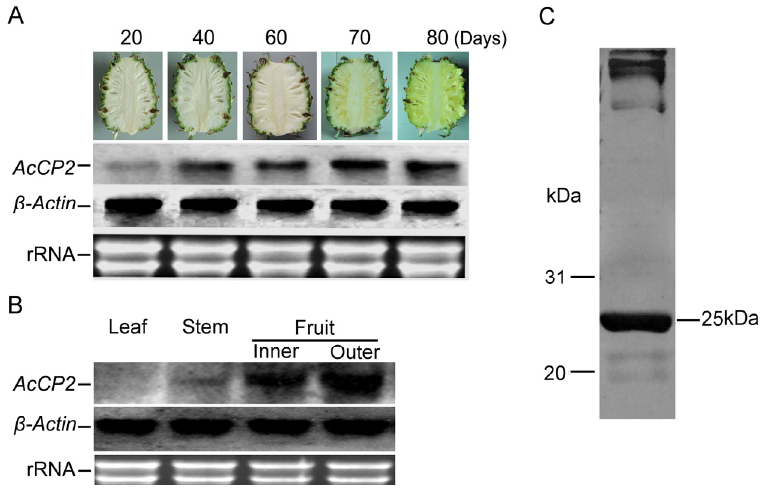
Figure 2. Temporal and spatial transcript levels of AcCP2 are analyzed by Northern blotting with specific probe primers. To ensure equal sample abundance on gels, rRNAs are quantified to monitor loading equivalence. β -Actin gene is used as an internal control. The data is used for analysis from at least three independent experiments ± SE ( n = 3). ( A ) The characteristics of AcCP2 transcription during fruit development and ripening; ( B ) Expression levels of AcCP2 in different tissues of pineapple; and ( C ) AcCP protein detection in pineapple fruits using purified